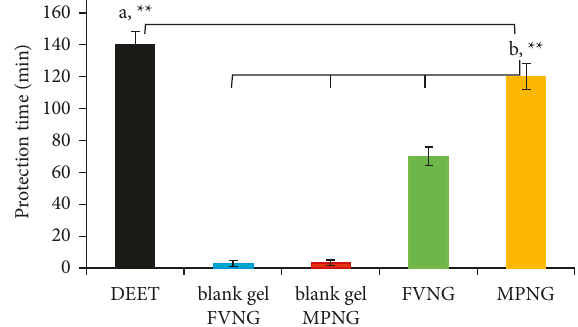
Figure 5: Complete protection times of nanogels containing F. vulgare and M. piperita EOs (FVNG and MPNG), blank gels (without EO), and DEETagainst An. stephensi . (a) Efficacy of DEET P 0 . 01). (b) The efficacy of MPNG is more is more than MPNG ( potent than FVNG and both blank gel ( 0 . ∗∗ < ∗∗∗